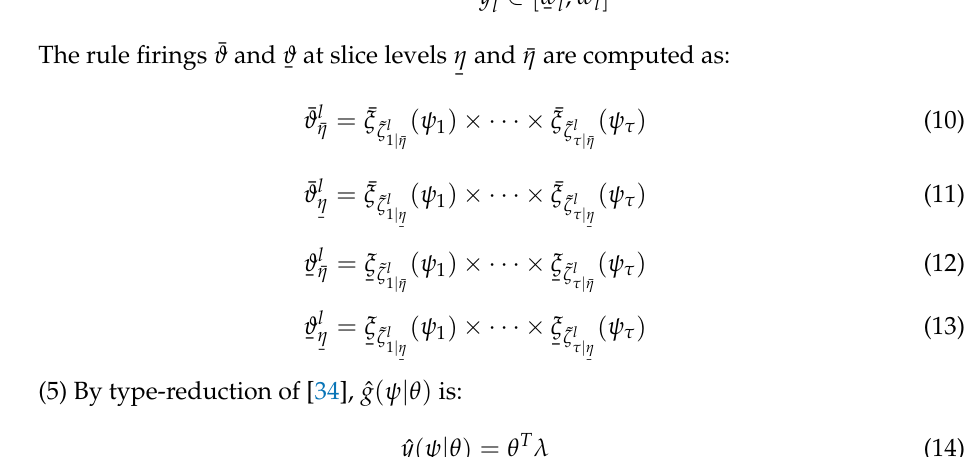
Figure 6. Non-singleton